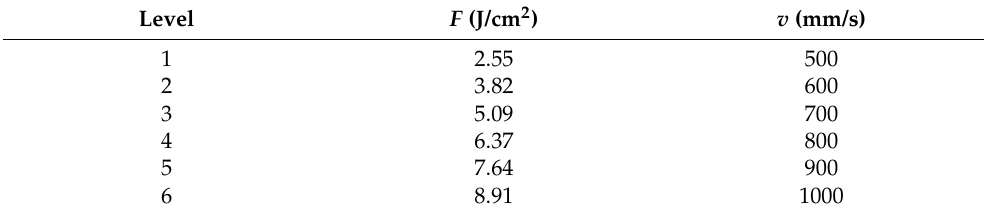
Table 2. Design scheme of the experimental factors and